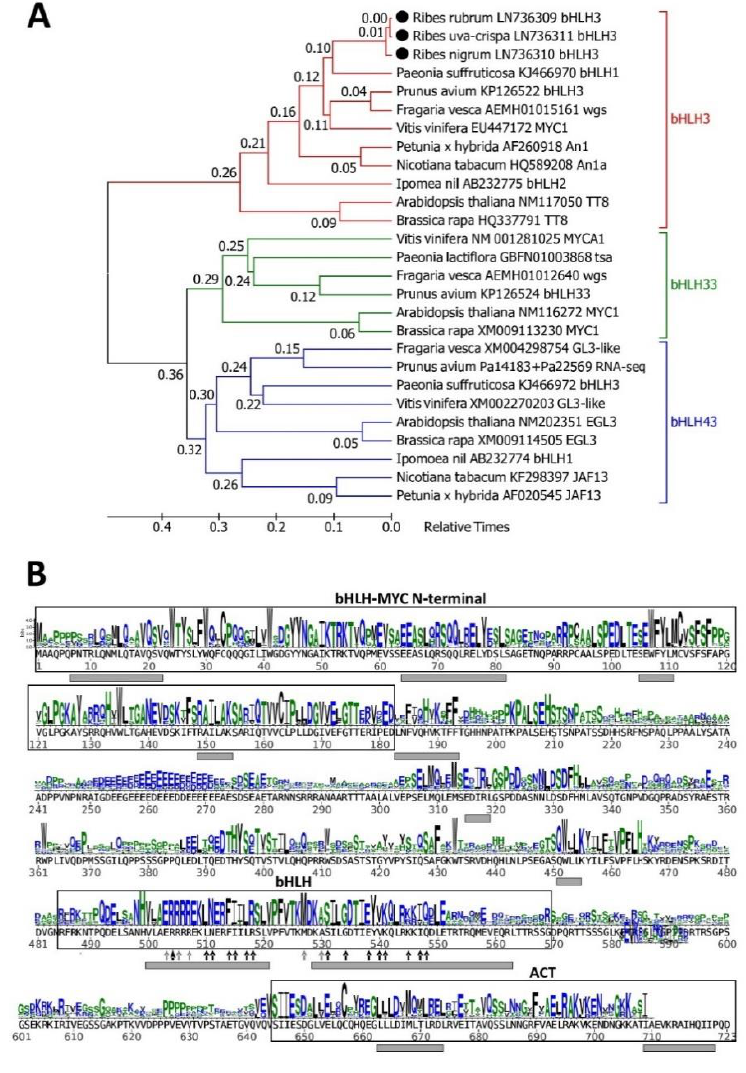
Figure 3. Ribes rubrum bHLH3 is homologous to other bHLH3-TT8 proteins. ( A ) A phylogenetic timetree of selected bHLH sub-group IIIf protein sequences. All proteins named with species name, accession number and original protein name. Sources of unnamed sequences: wgs, genes identified from NCBI Whole Genome Sequencing database; tsa, sequences identified from NCBI Transcriptome Shotgun Assembly sequence database; RNA-seq, cDNA from whole transcriptome study. ( B ) Sequence logo representing an alignment of 80 bHLH3-like proteins from di ff erent species of the Pentapetalae taxonomic branch. Empty boxes denote protein domains as defined in NCBI’s Conserved Domain Database. Gray boxes beneath the sequence specify helixes as predicted by PSIPRED. Gray arrows point to amino acids involved in DNA binding; black arrows point to amino acids involved in the dimerization interface; black arrow with long head points to amino acid essential to E-box specificity.